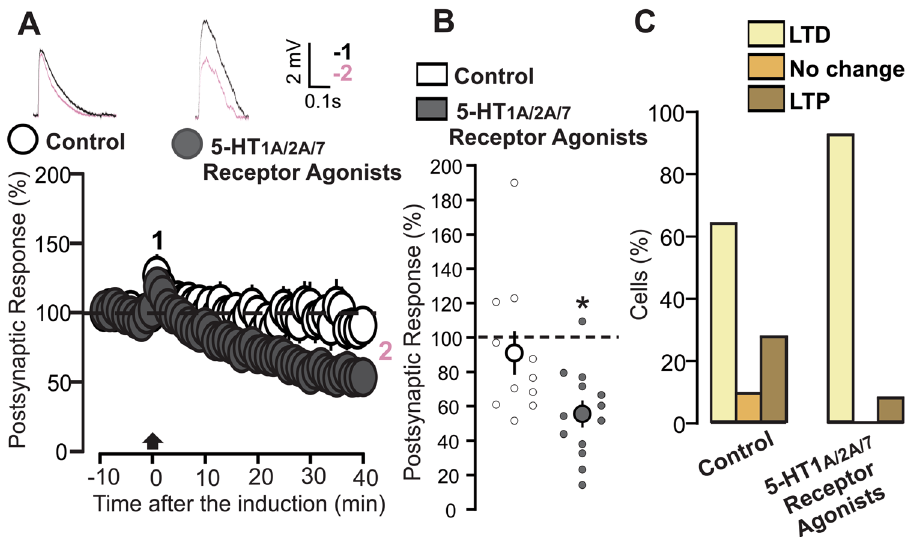
Figure 8. Application of three 5-HT 1A/2A/7 receptors agonists induces LTD. ( A ) The graph shows the EPSPs recorded in P14-16 animals before and after TBS induction. The EPSPs were normalized to the mean of responses recorded during the baseline. Two different conditions are compared: control (white inserts) and 5-HT 1A/2A/7 receptor agonists (dark grey inserts: TCB-2, 10 µM, 8-OH-DPAT, 1 µM LP-44, 2 µM). Traces show the results of a representative experiment with the average of postsynaptic responses recorded before (1: baseline, − 5 to 0 min, black line) and after the TBS induction (2: post induction, 35–40 min, black line). ( B ) Scatter graph showing the averaged EPSPs recorded during the 35–40 min period after TBS induction, for individual experiments (small dots) and for the mean values of the experimental group (large dots, with bars representing the SEM). Two experimental groups are compared based on the condition of drug incubation: control and 5-HT 1A/2A/7 receptors agonists (TCB-2, 10 µM, 8-OH-DPAT, 1 µM LP-44, 2 µM). EPSPs values were normalized to the mean of responses recorded during the baseline. ( C ) The graph shows the percentage of cells exhibiting LTP, LTD or no change in two experimental groups: control and 5-HT 1A/2A/7 receptors agonists (TCB- 2, 10 µM, 8-OH-DPAT, 1 µM LP-44, 2